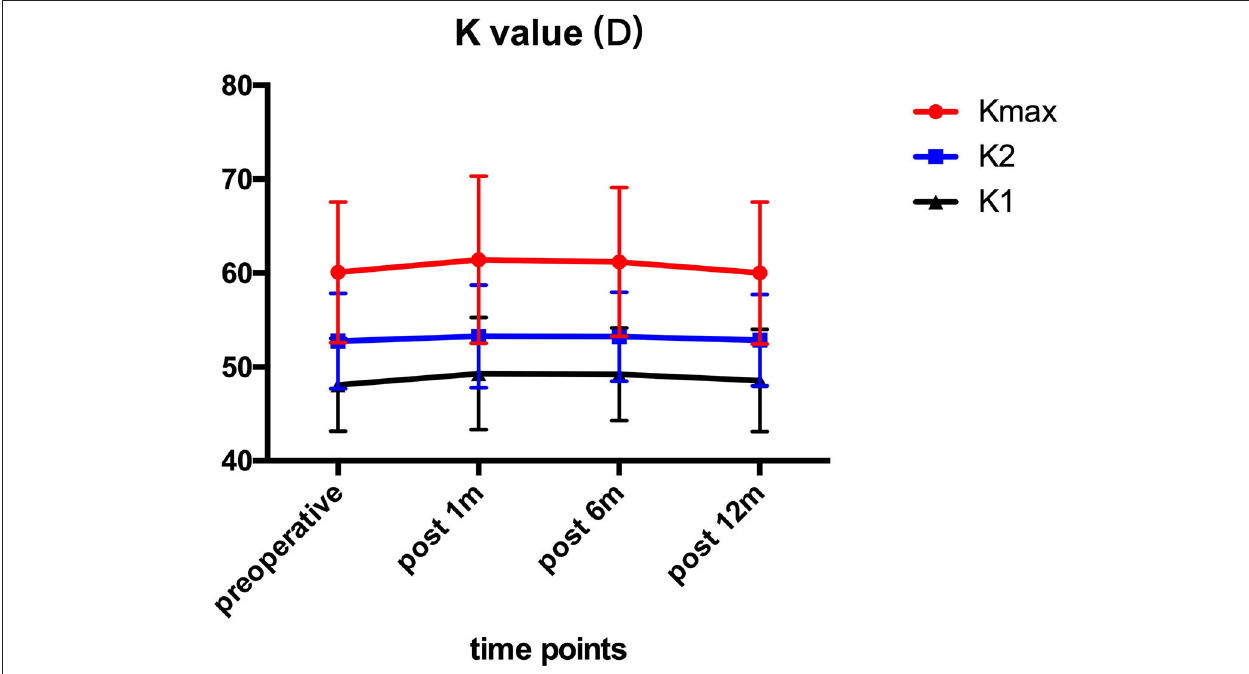
FIGURE 1 | K1, K2, and Kmax before and after ATE-CXL during 1-year follow-up. There was no statistically significant ( P > 0.05) alteration at each visit in comparison to preoperative values. (K1, steepest meridian keratometry; K2, flattest meridian keratometry; Kmax, maximum keratometry; ATE-CXL, accelerated transepithelial corneal